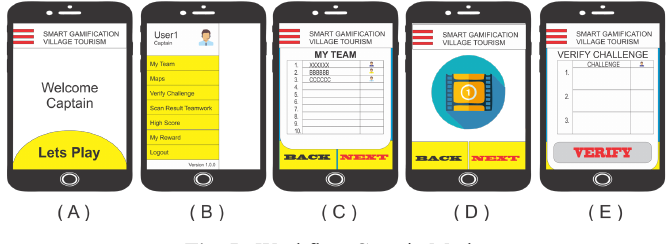
Fig. 5. Workflow Captain Mode.